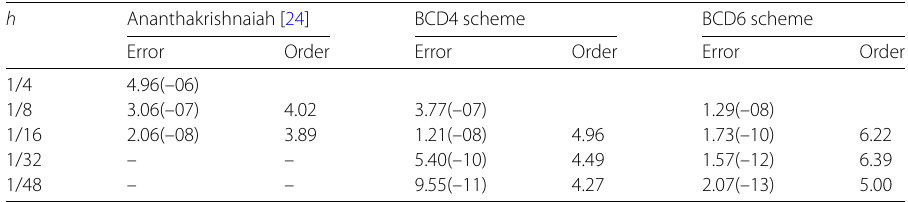
Table 5 The maximum error and average convergence order for Problem 5 h Ananthakrishnaiah